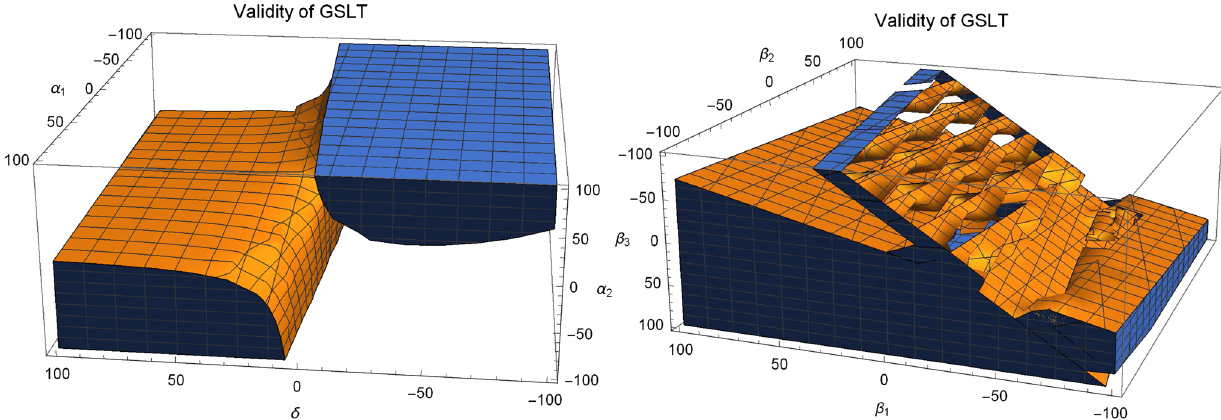
Fig. 8 Left and right plots represent the possible validity regions for logarithmic corrected entropy in terms of cosmographic parameters for both F models